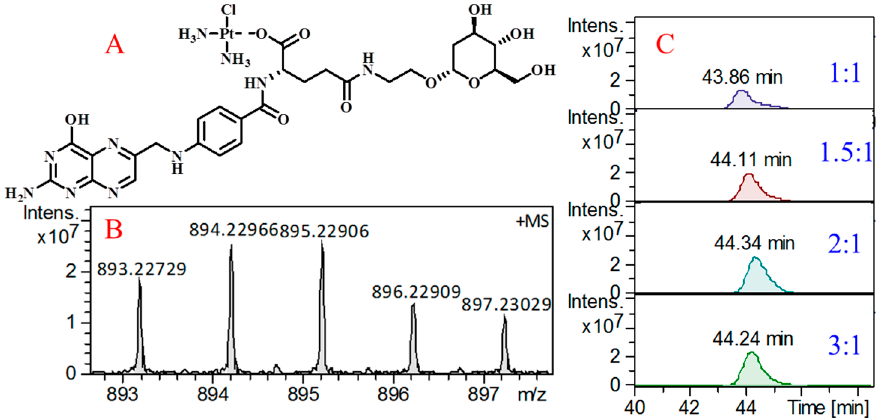
Figure 6. The structural characteristics of the compound. ( A ) Structure of the compound after the formation of the coordination bond; ( B ) Quasimolecular ion peaks of the precise molecular mass of this compound; ( C ) Extracted ion chromatogram at 895.22906 with different molar ratios.